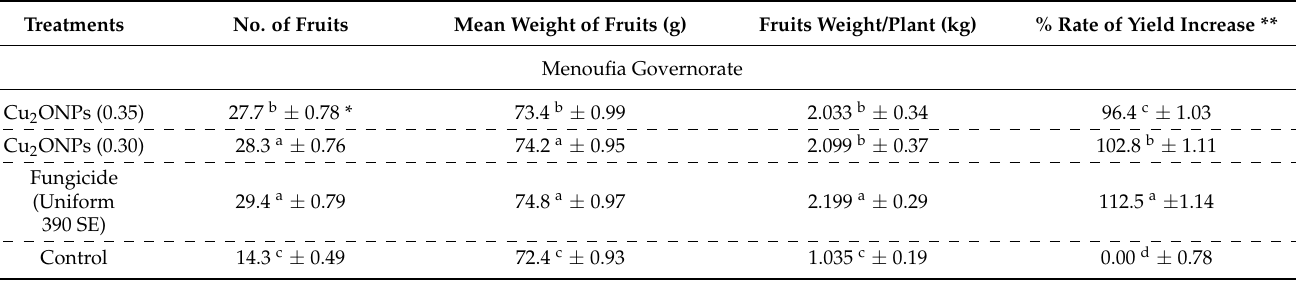
Table 7. Effect of Cu 2 ONPs compared to the chemical fungicide on yield parameters of cucumber plants under field conditions in Menoufia and Giza